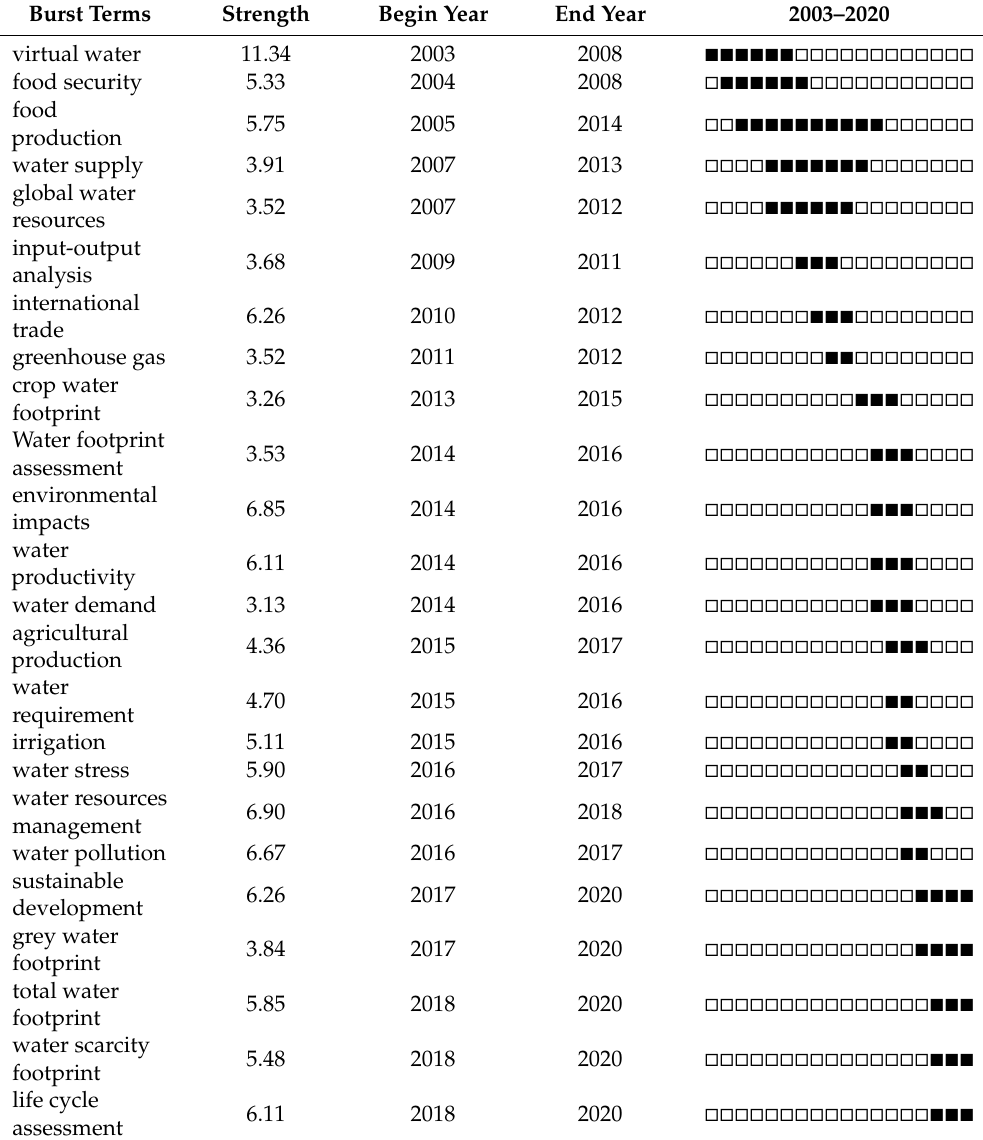
Table 1. Burst terms of virtual water and water footprint